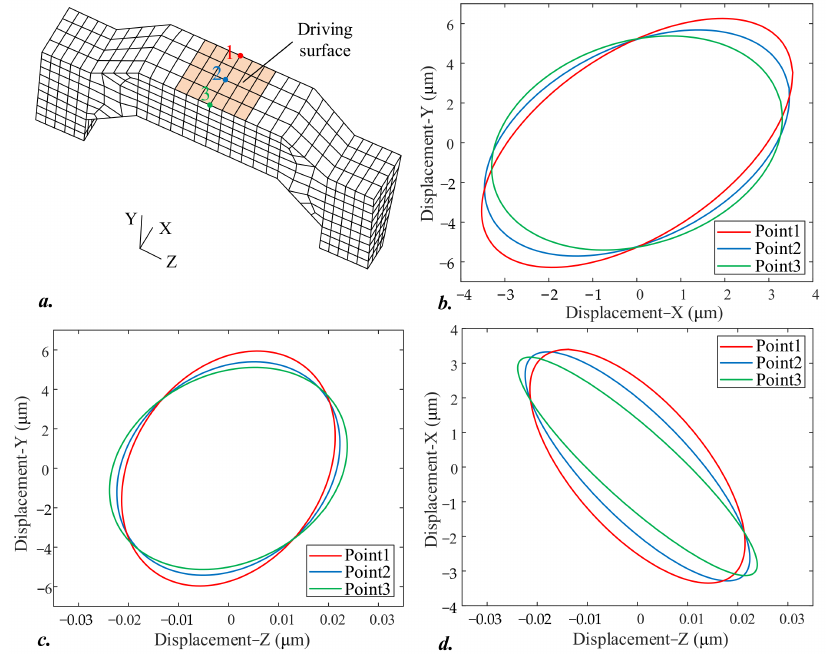
Figure 10. Elliptical motion trajectories of three points on the driving surface: ( a ) 3D mesh model of one stator tooth; ( b ) elliptical motion trajectory on XY-plane; ( c ) elliptical motion trajectory on ZY-plane; ( d ) elliptical motion trajectory on